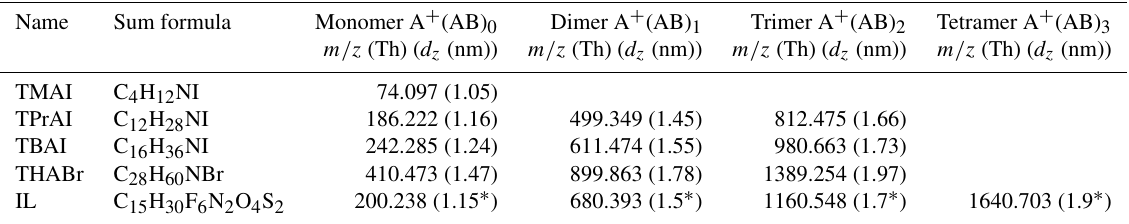
Table 2. Positive cluster ions, their corresponding mass-to-charge ratio m/z and the mobility diameter d z of